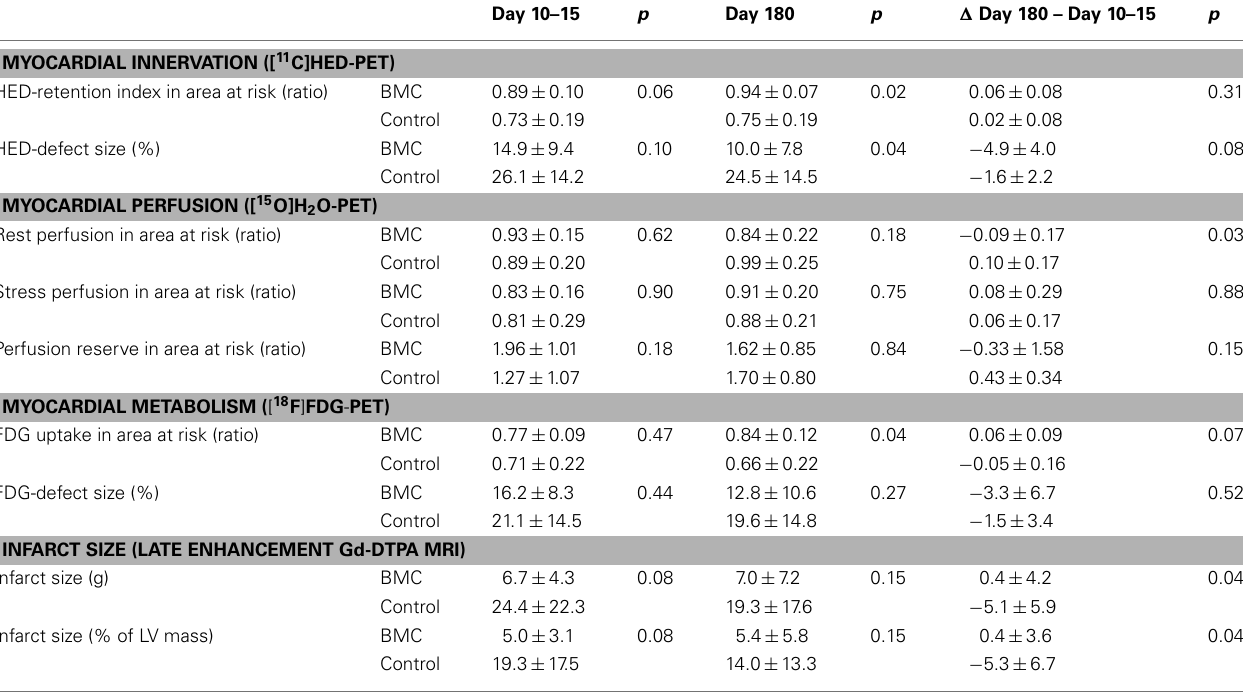
Table 2 | Effect of mononuclear stem cell therapy on myocardial innervation, perfusion, metabolism, and infarct size measured by cardiac PET and